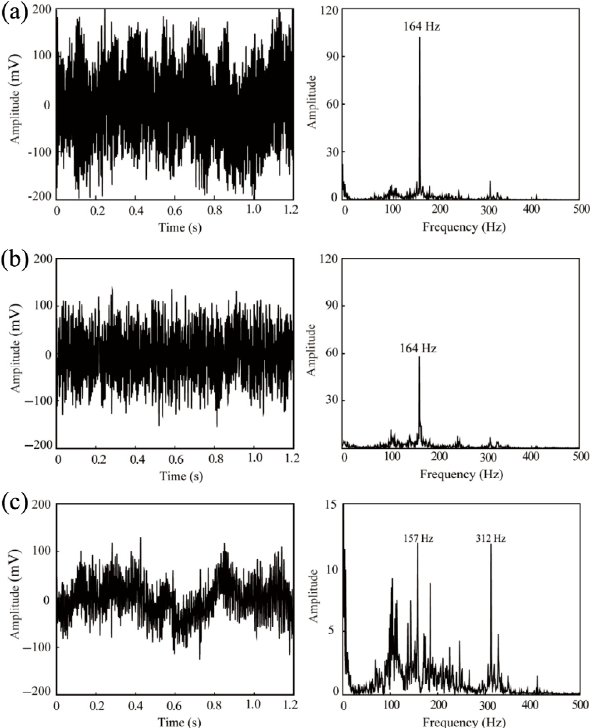
Fig. 3 Typical time-domain signals and frequency spectra of (a) original vibration signal, (b) no-load vibration signal, and (c) filtered vibration signal. All signals were collected under a velocity of 15 mm/s and a normal load of 1.0 N for sample #5.